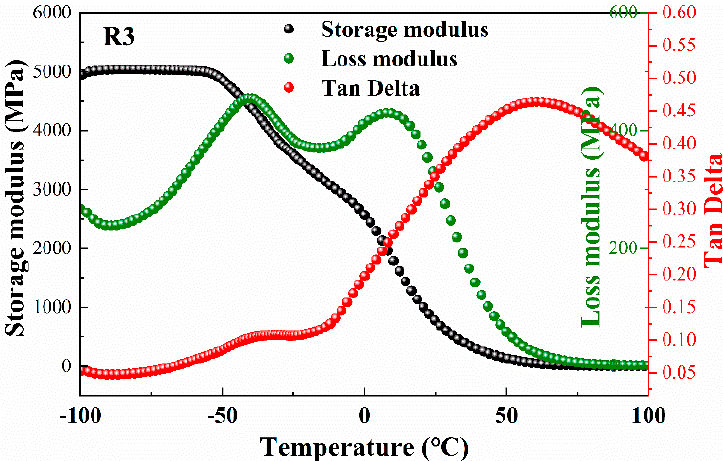
Figure 2. The E ′ , E ″ and Tan δ curves of R3 propellant. Figure 2. The E (cid:48) , E ” and Tan δ curves of R3 propellant. The E (cid:48) , E ” and Tan δ plots of the blank EMDB propellant (R0) are shown in Figure 3. It is obvious that the trends of change for the three curves were similar with that of the R3 propellant plasticized by Bu-NENA, while the transition temperatures differed. The T β of the R3 was − 38.1 ◦ C, which is lower than that of R0 ( − 33.8 ◦ C). The difference mainly arose from the more obvious reduction in Bu-NENA on the intermolecular forces between the adhesive molecules, which endowed Bu-NENA with a better plasticization effort. The motion of side groups in the NC molecule of R3 propellant could occur more readily than in R0 propellant, which is to say the activation energy of molecular motion of R0 is lower. Furthermore, the elastic deformation energy of R0 is more easily dissipated and converted into heat [25]. Therefore, the β -transition temperature of R3 decreased by a couple of degrees. As for the α -transition, the T α of the R3 propellant was similar to that of the R0 propellant. This might have been caused by the influence of RDX fillers on the double-base adhesive. There are inducing forces between the nitramine groups in RDX and the nitrate ester group in the adhesive. This kind of intermolecular force is less affected by temperature compared with the interaction force between NC molecules such as hydrogen bonds. The difference in the mentioned interaction force between the R3 and R0 propellants was weakened due to the temperature rising. However, the RDX content in R3 was slightly higher than that in R0, which was not conducive to the motion of adhesive molecules in the R3 propellant. Accordingly, the T α of the R3 propellant was similar with that of the R0